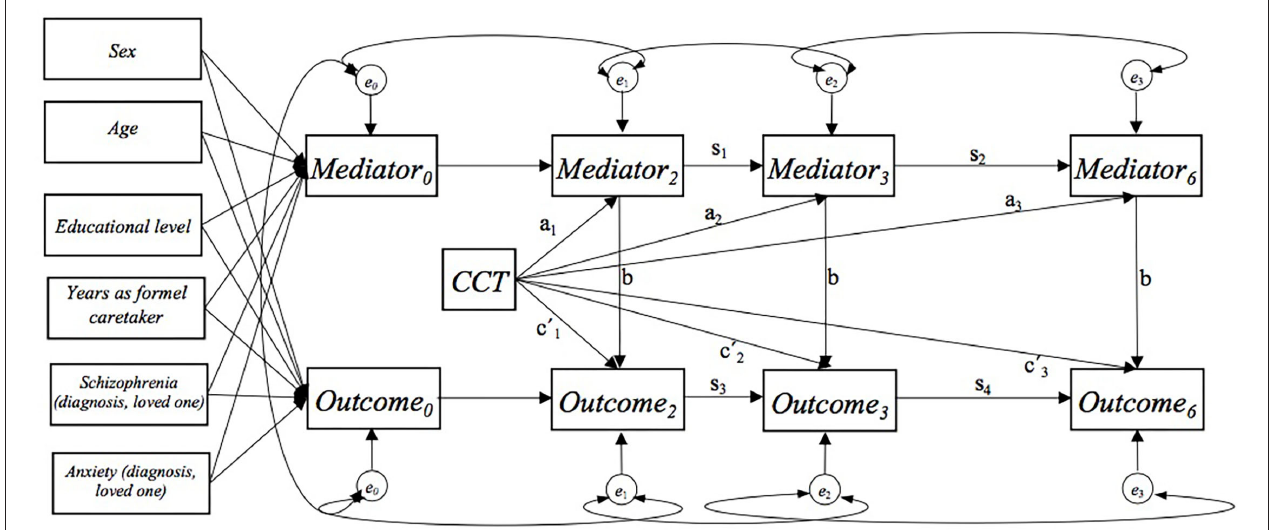
FIGURE 1 | Autoregressive model with a single mediator showing the a, b, and c ′ paths. At baseline, residual covariance between all mediators and outcome. For each mediator and the outcome residual covariance over time.